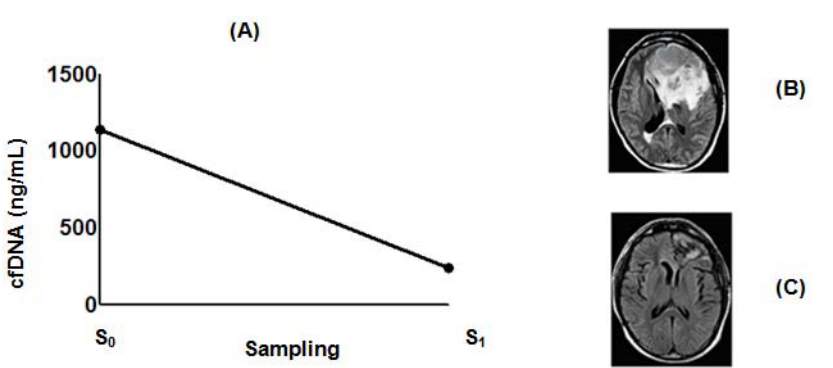
Figure 6. Figure of a patient with brain metastasis from prostate adenocarcinoma IV under ITN-POH based therapy. Initial brain image ( B ) corresponding to high levels of circulating cfDNA at the time of ITN-POH protocol inclusion ( A , S 0 = 1140 ng/mL; June 2006). ITN-POH therapy caused a five-fold decrease of circulating cfDNA ( A , S 1 = 234 ng/mL; December 2006) with MRI pattern compatible with stable disease ( C ).